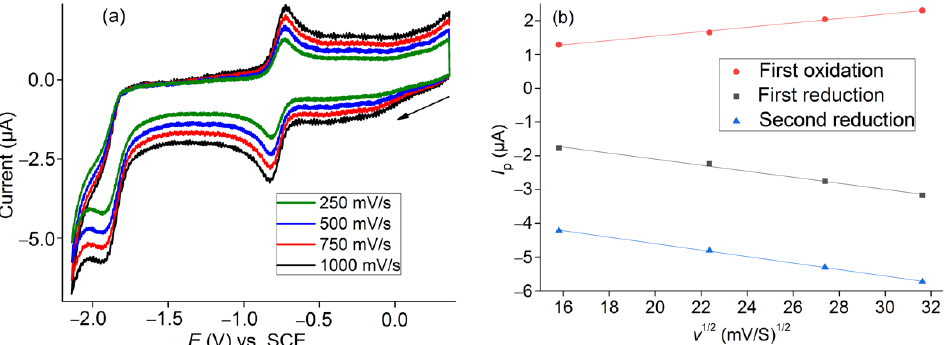
Figure 3. ( a ) Cyclic voltammograms of [Co(TTMPP)] in 0.1 M n- Bu 4 NBF 4 /DMF under an Ar atmosphere recorded at different scan rates. ( b ) Peak currents vs. square roots of the scan rate for the two reductions and the first oxidation process.